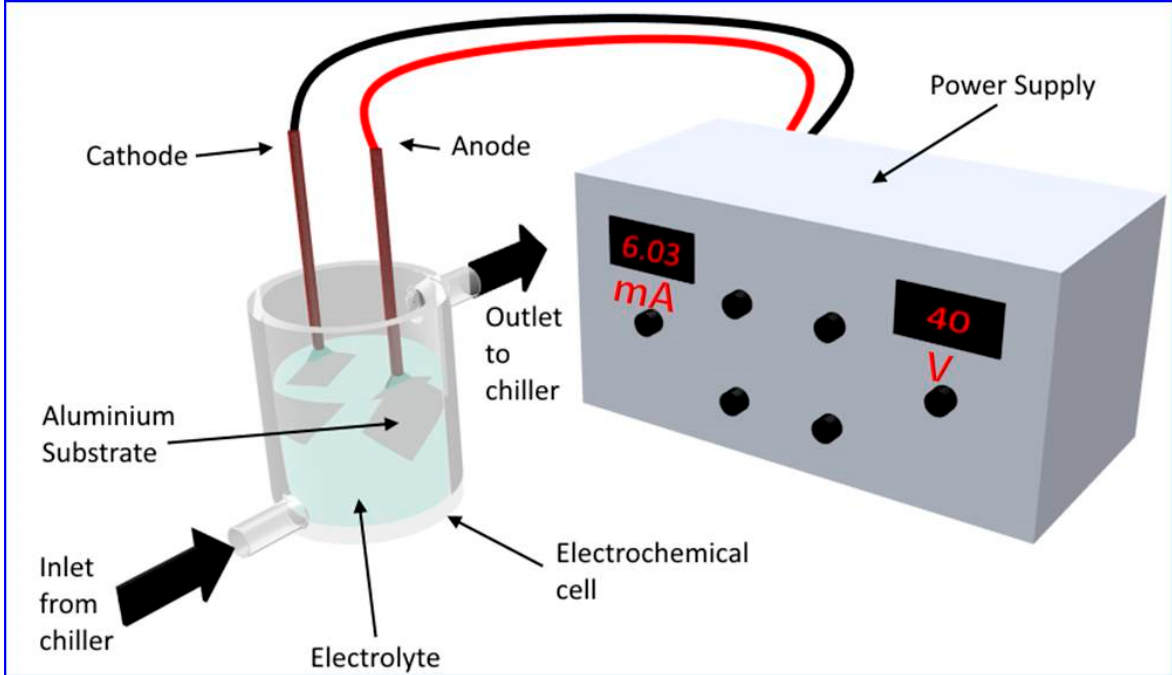
Figure 1. Typical experimental setup for the fabrication of NAA.